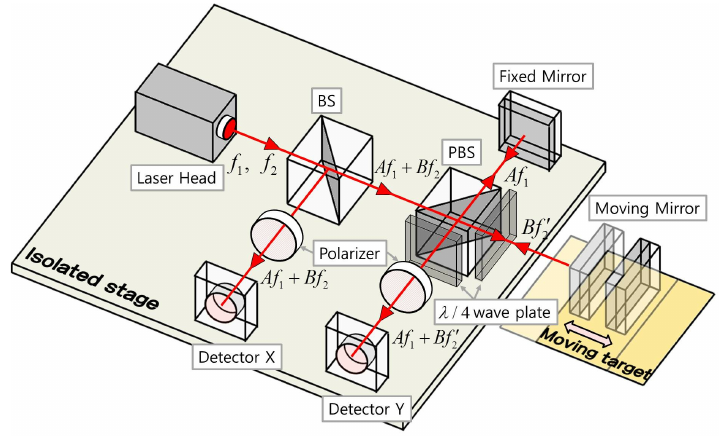
Figure 2. Heterodyne laser interferometer